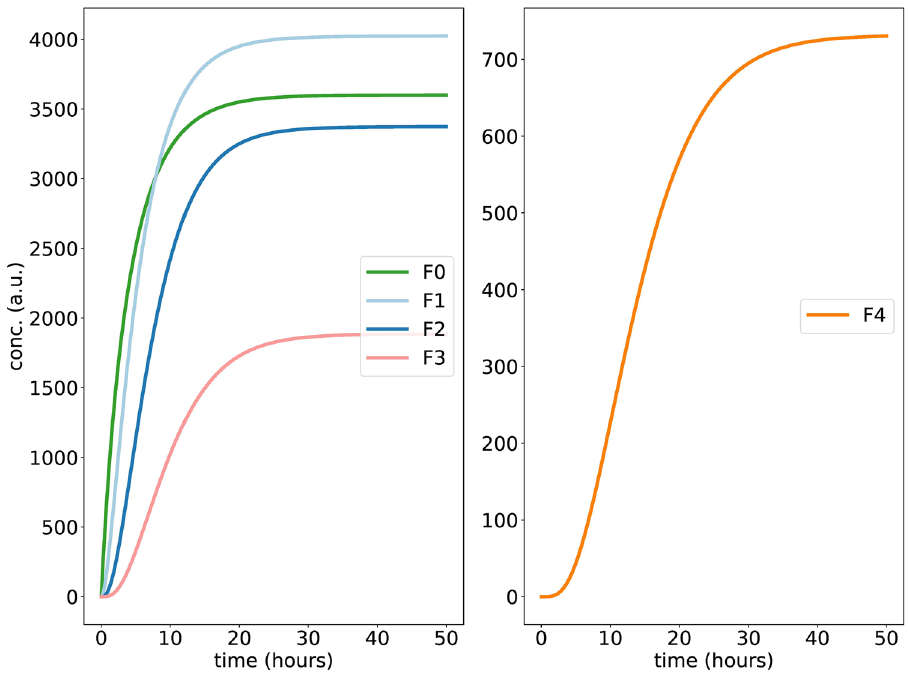
Figure 6. Simulating nonlinear random phosphorylations: Graphs show time-courses of hypo, medium, hyperphosphorylated and fully phosphorylated F proteins for n = 4